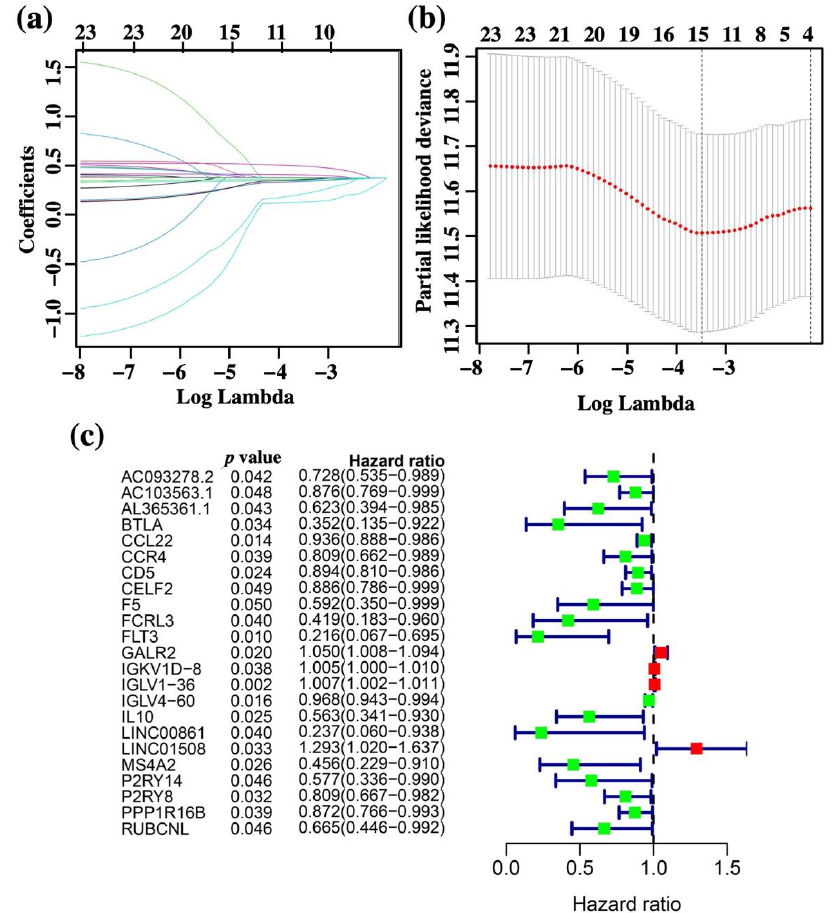
Figure 7. Univariate Cox and LASSO Cox survival analysis for the DEGs based on PPI analysis in OSCC patients. ( a ) Univariate Cox survival analysis of the DEGs. ( b , c ) LASSO Cox analysis identified 23 DEGs with the prognostic value and 23 DEGs were identified as prognostic factors of OSCC patients. Protective factors mean the genes’ HR was <1, while risk factors mean the genes’ HR was >1 in OSCC patients.